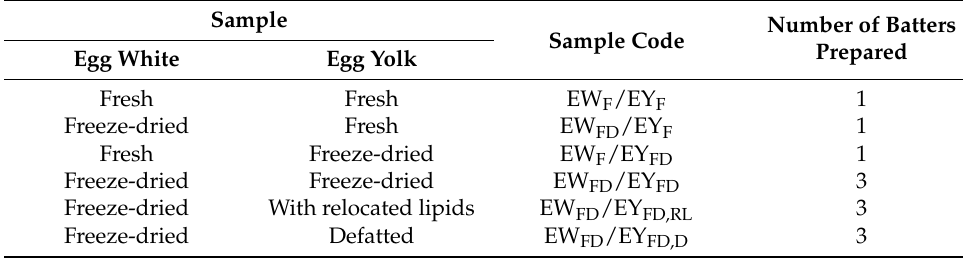
Table 1. Sample codes of sponge cake (batter) prepared with different egg white and egg yolk treatments prior to batter preparation. Egg white was either fresh or freeze-dried. Egg yolk was fresh, freeze-dried or freeze-dried and treated with a solvent (egg yolk with relocated lipids or defatted egg yolk). Sample Number of Sample Code